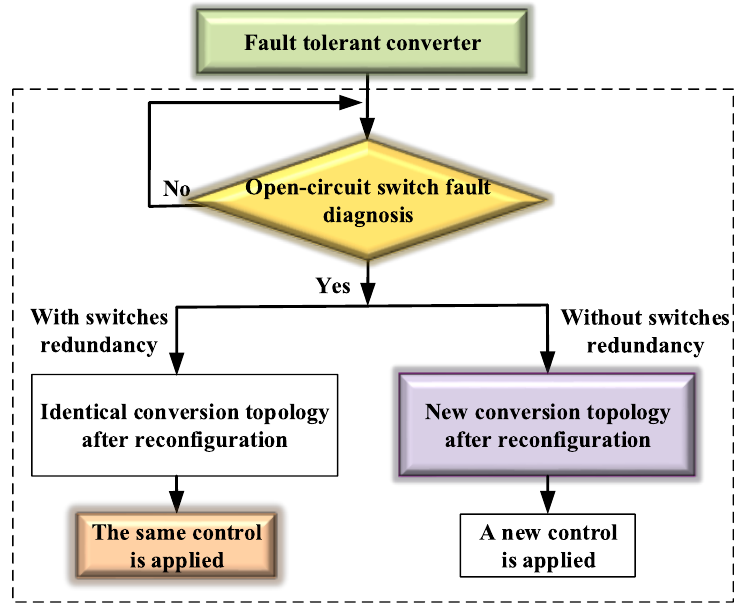
Figure 2. Typical service continuity